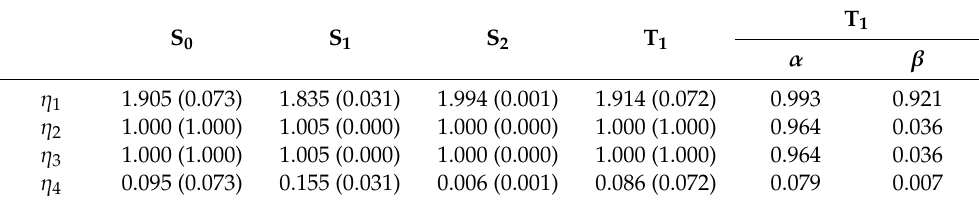
Table 2. Active-space NO occupation numbers for the S 0 , S 1 , S 2 and T 1 states of square C 4 H 4 and active-space NSO occupation numbers for the T 1 state (all in descending order). Values in brackets show the net contributions from all determinants in which a particular NO is singly occupied.